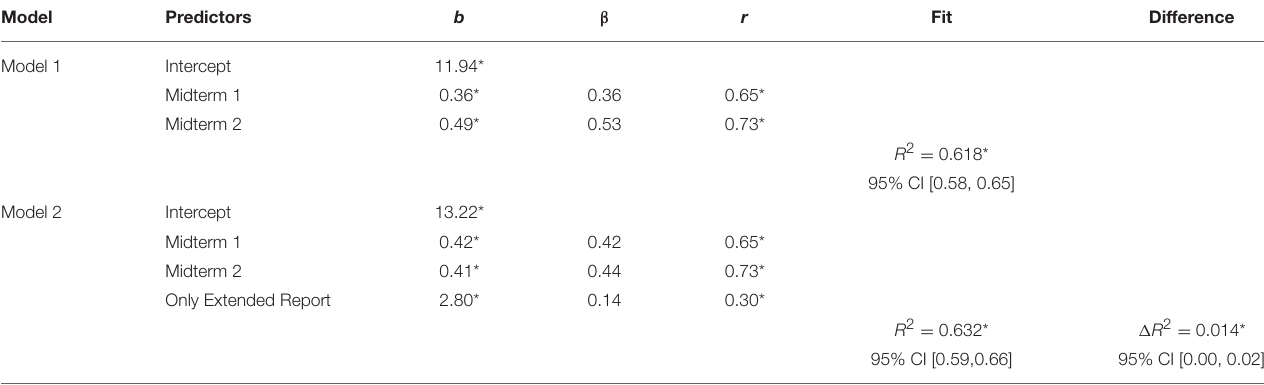
TABLE 4 | Hierarchical regression results for study 2.